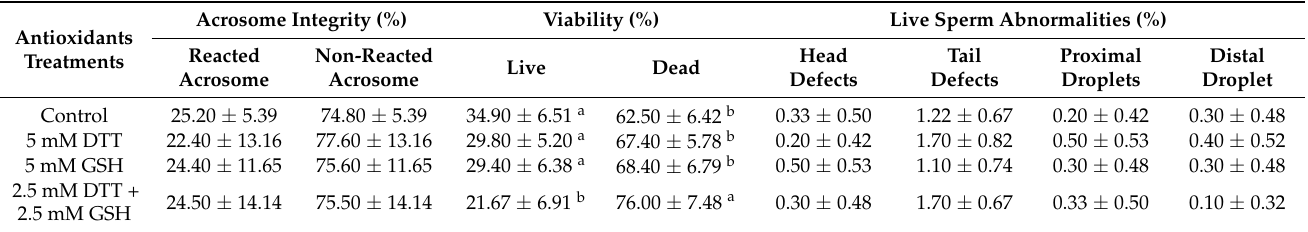
Table 7. Characterization of sperm viability, morphology, and acrosome integrity of frozen-thawed Large White boars’ semen supplemented with antioxidants (mean ± SD).